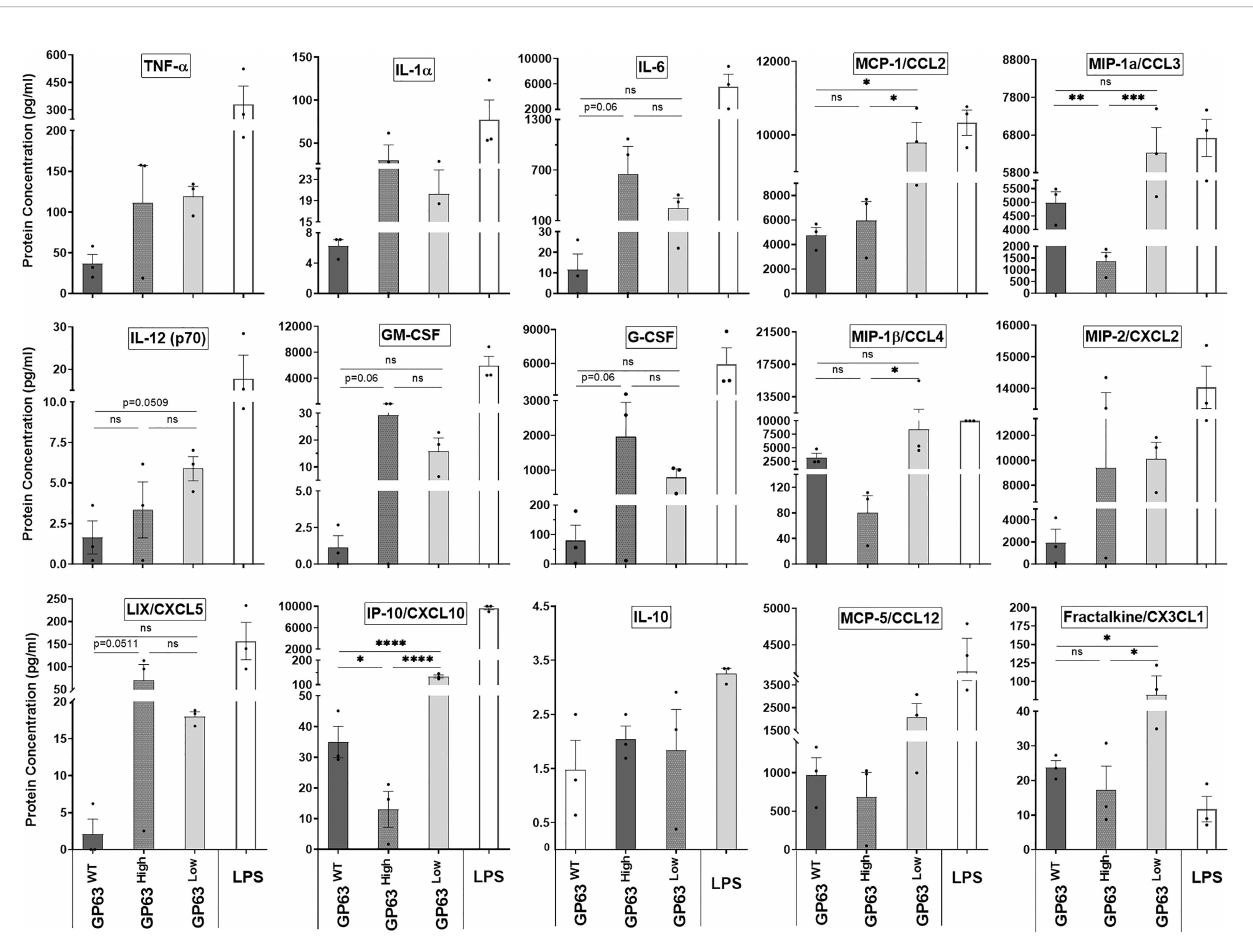
FIGURE 5 | Impact of various Leishmania amazonensis species and their derived EVs stimulation on the in fl ammatory response protein expression of innate immunity cells. Supernatant protein levels of immortalized bone marrow macrophages (B10Rs) in-vitro stimulated with Leishmania -derived EVs measured by multiarray ELISA assay; Ordinary one-way ANOVA test with multiple comparisons by Uncorrected Fisher`s LSD test; *p < 0.05; **p < 0.01; ***p < 0.001; ****p < 0.0001; No symbol, nonsigni fi cant; Bars=Average ± SEM;